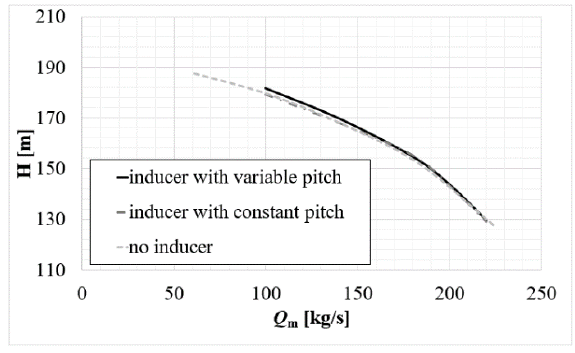
Fig. 12. H-Q characteristic [3]